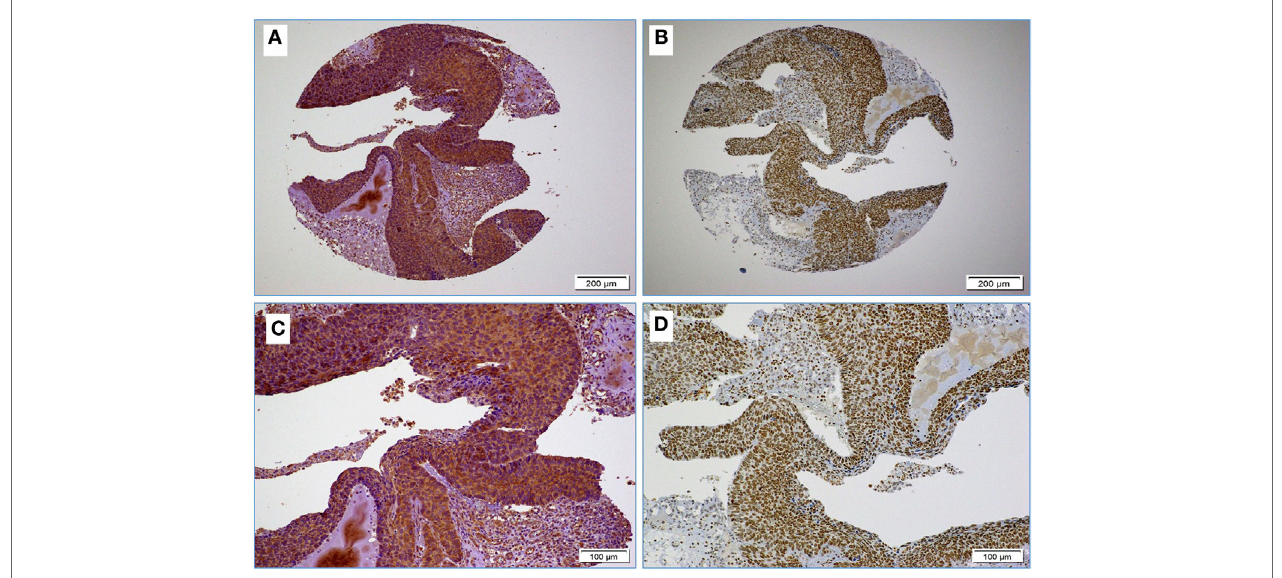
FigUre 1 | (a,B) Images reflect the diffused and strong cervical cancer cell positivity for high-risk HPV (E6 onco-protein) (a) and Epstein–Barr virus (EBV) (LMP1 protein) (B) (10 × magnification); images (c,D) High-risk HPV and EBV positivity at higher magnification (D) ; as shown, EBV positivity is clear in some stromal cells and tumor infiltrating lymphocytes (arrows) (D) (20 × magnification).